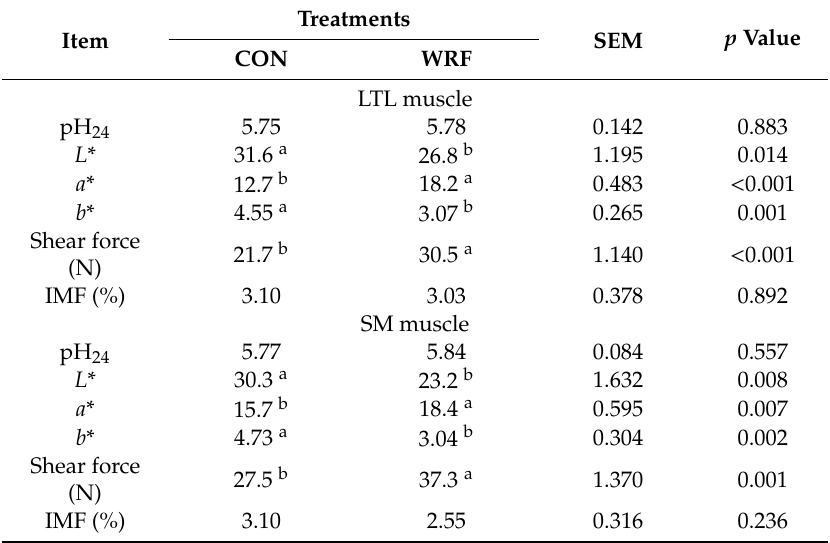
Table 2. E ff ects of dietary-fungal-pretreated corn straw on traits of longissimus thoracis et lumborum (LTL) and semimembranosus (SM) muscles of lambs infected with gastrointestinal nematodes. Treatments Item SEM